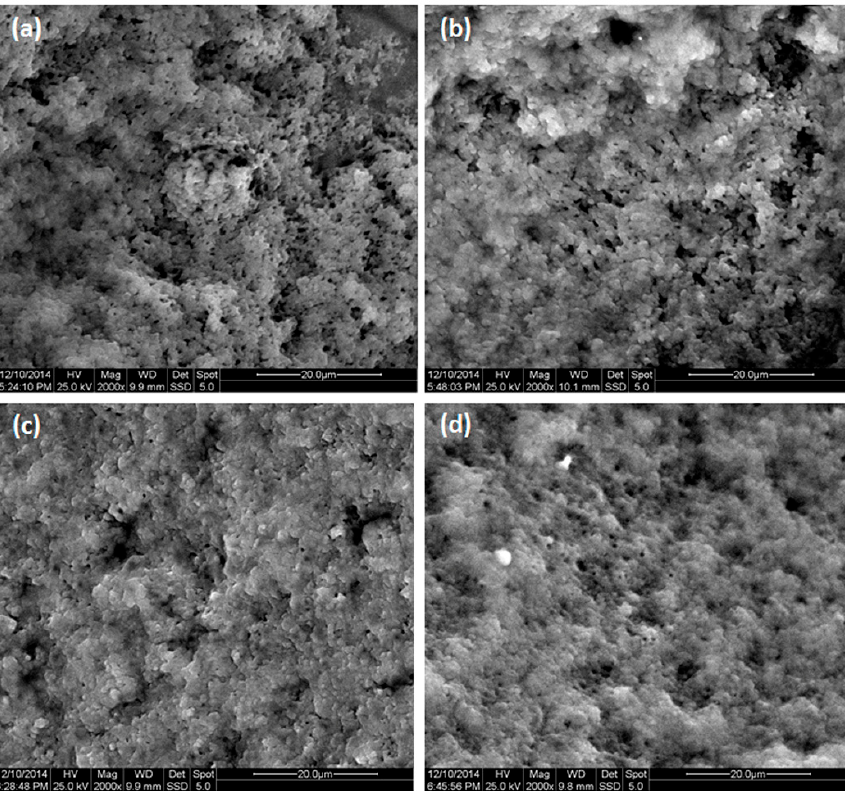
Figure 1. Scanning electron micrographs ( × 2000) of bovine yoghurt prepared from thermally treated ( a ), thermal–TGase-treated ( b ), HP-treated ( c ) and HP–TGase-treated milk ( d ), respectively. 3.3. E ff ect of Milk Type, Applied Treatment and Storage Time on the Anti-Hypertensive Activity of